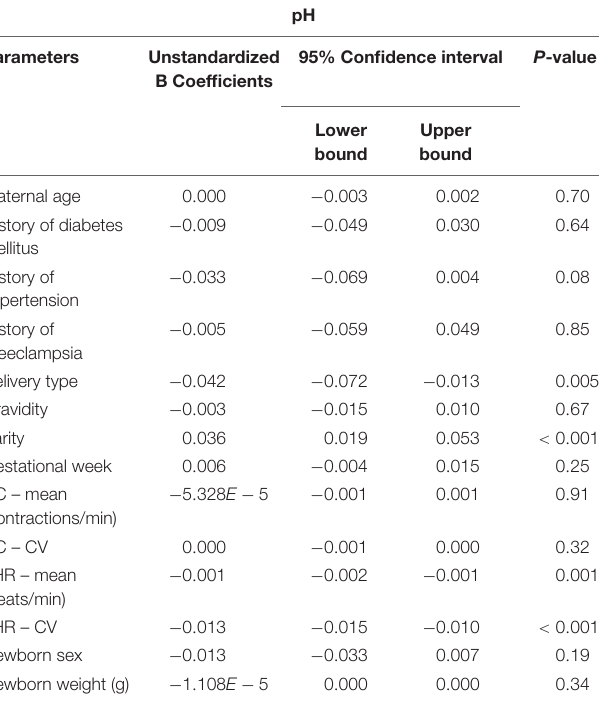
TABLE 2 | Association between maternal and newborn parameters and pH.